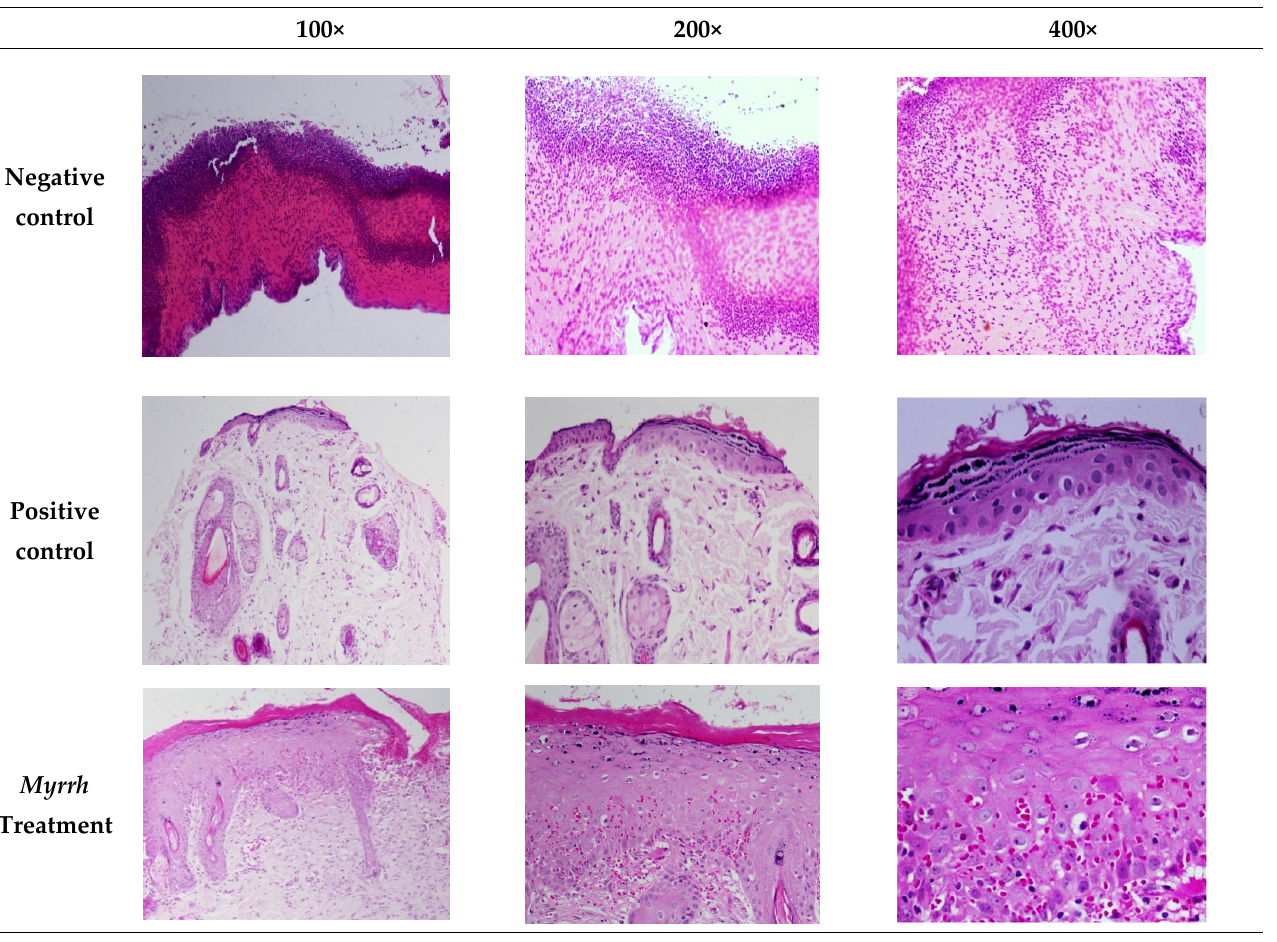
Table 3. Prediction of biological activity of myrrh methanolic extracts.